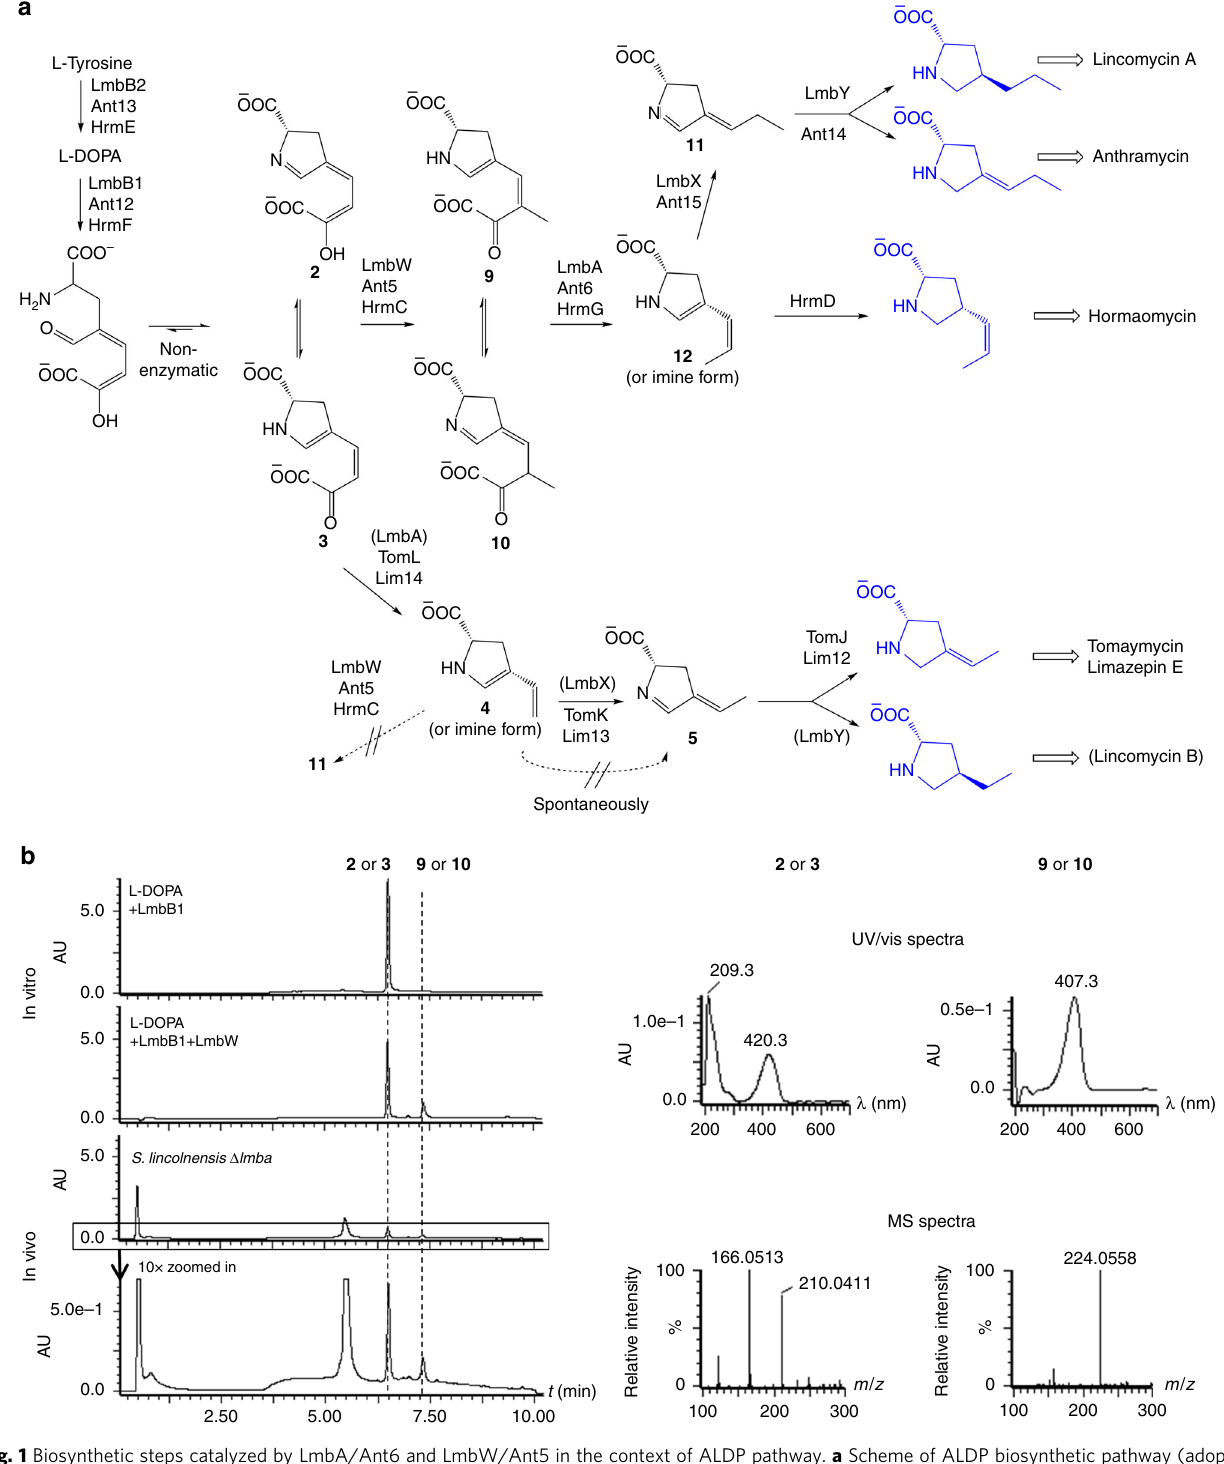
Fig. 1 Biosynthetic steps catalyzed by LmbA/Ant6 and LmbW/Ant5 in the context of ALDP pathway. a Scheme of ALDP biosynthetic pathway (adopted from Jiraskova et al. 2 and modi fi ed according to Kamenik et al. 10 ); Dotted arrows indicate steps proposed by Zhong et al. 1 , brackets indicate a side- pathway, fi nal ALDP precursors highlighted in blue are incorporated into the secondary metabolites. b In vitro (experiments from Jiraskova et al. 2 re- examined using a more suitable chromatographic method) and in vivo (new experiments) C -methylation of 2 / 3 by LmbW; Chromatographic conditions: UPLC BEH Amide 1.7 µ m, 2.1 × 50 mm column (Waters, USA), mobile phase: A-acetonitrile and B-50 mM ammonium acetate pH8:acetonitrile 1:1 ( v/v